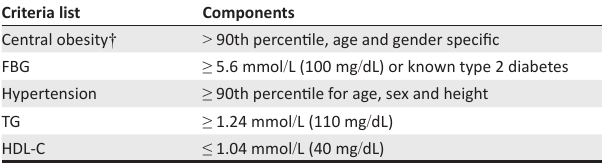
TABLE 1: Criteria for the metabolic syndrome are listed below and can be any three of